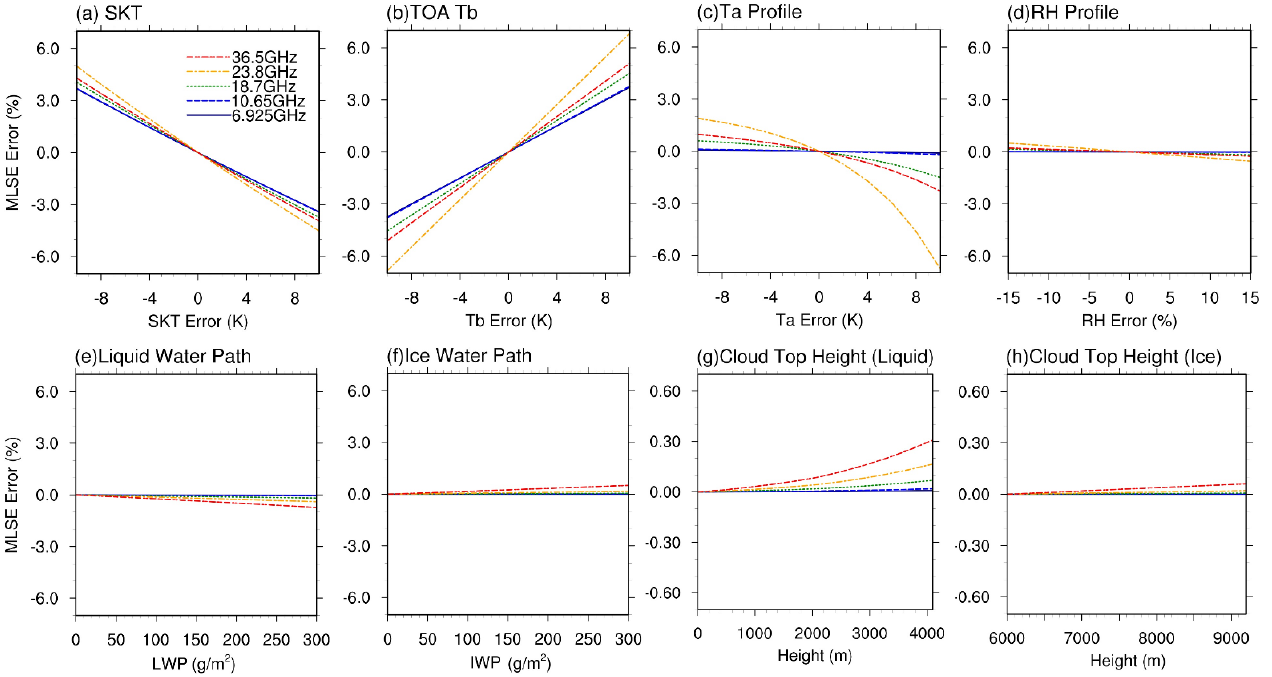
Figure 5. Sensitivity analysis of MLSE to the error introduced by primary inputs: (a) skin temperature (SKT), (b) TOA brightness temperature (Tb), (c) air temperature (Ta) profile, (d) relative humidity (RH) profile, (e) liquid water path (LWP), (f) ice water path (IWP), and cloud top height (g: liquid phase, h: ice phase).